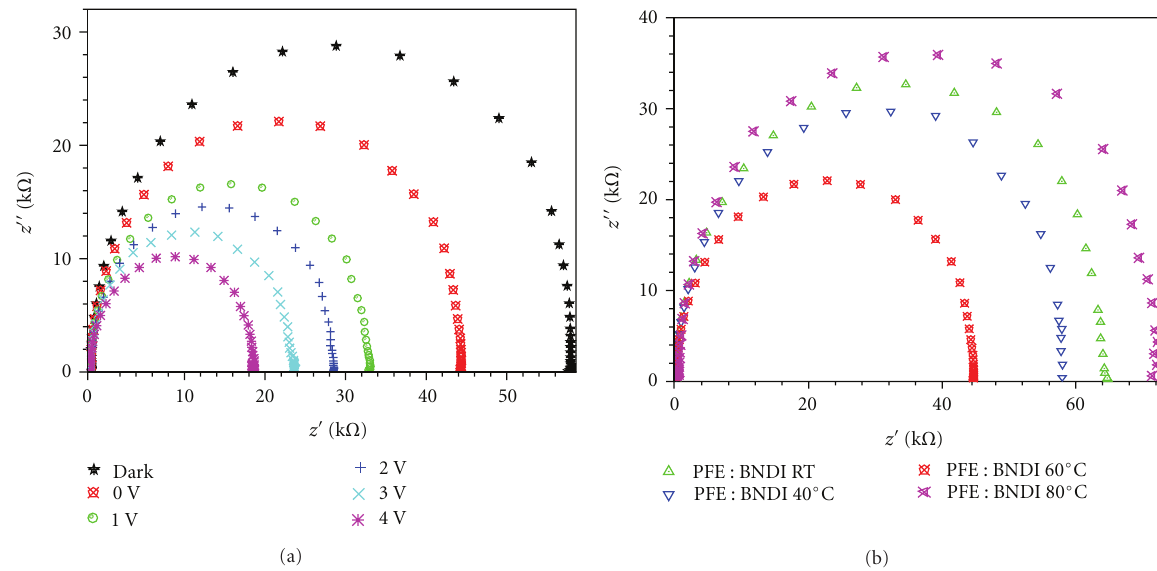
Figure 9: Complex impedance plot of ITO/PEDOT:PSS/PFE:BNDI (3: 1) ∗ /Al, ∗ : (a) 60 ◦ C in dark and under 1mW/cm 2 at di ff erent reverse bias voltages and (b) at RT, 40 ◦ C, 60 ◦ C, and 80 ◦ C under 1mW/cm 2 at 368 nm ( V appl = 0V).